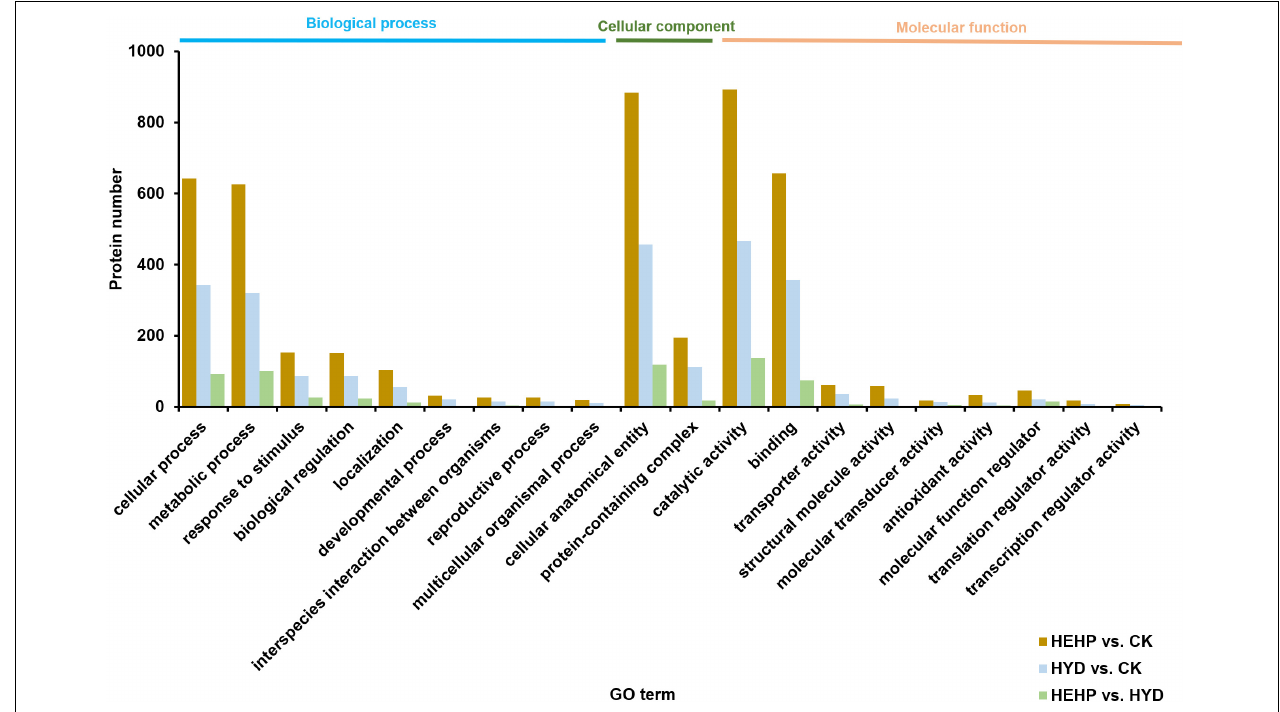
FIGURE 4 | Gene ontology (GO) annotation of DAPs in HEHP vs. CK, HYD vs. CK and HEHP vs.